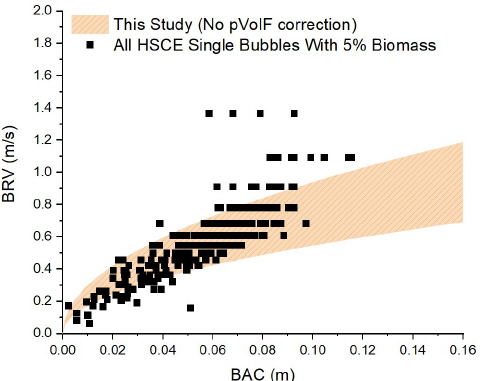
Figure 8. BRVs and BACs for single bubbles of all sizes, injected in the presence of 5 vol% biomass. Notes: (i) data points were obtained using the CREC-Optiprobes and the proposed HSCE model [19]; (ii) probabilistic predictive model (PPM) bands are set as proposed in the present study. Figure 9 further reports the behavior of single bubbles in a sand bed with 10 vol% of biomass, as detected using the CREC-Optiprobes, and calculated by employing the HSCE model. One can see that the resulting bubbles are even smaller in this case, given the greater amount of biomass pellets in the bed, which act as bubble breakers. These bubbles all fall inside the set PPM bands.